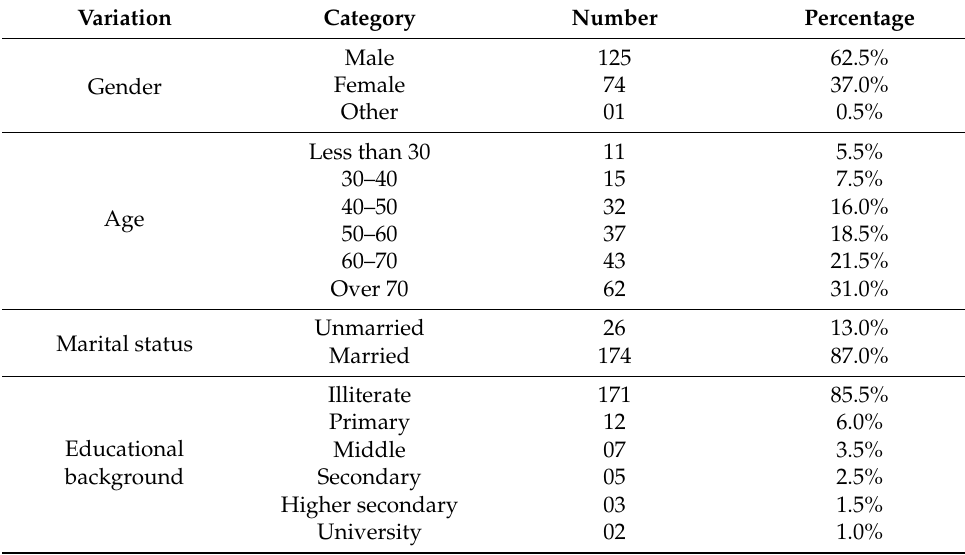
Table 1. Demographic characteristics of the